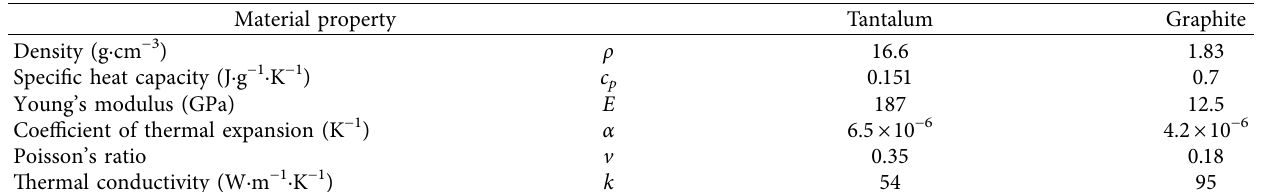
Table 2: Overview of the material properties of tantalum and polycrystalline graphite SGL R6650 used in the coupled transient thermal/ transient structural ANSYS simulation.